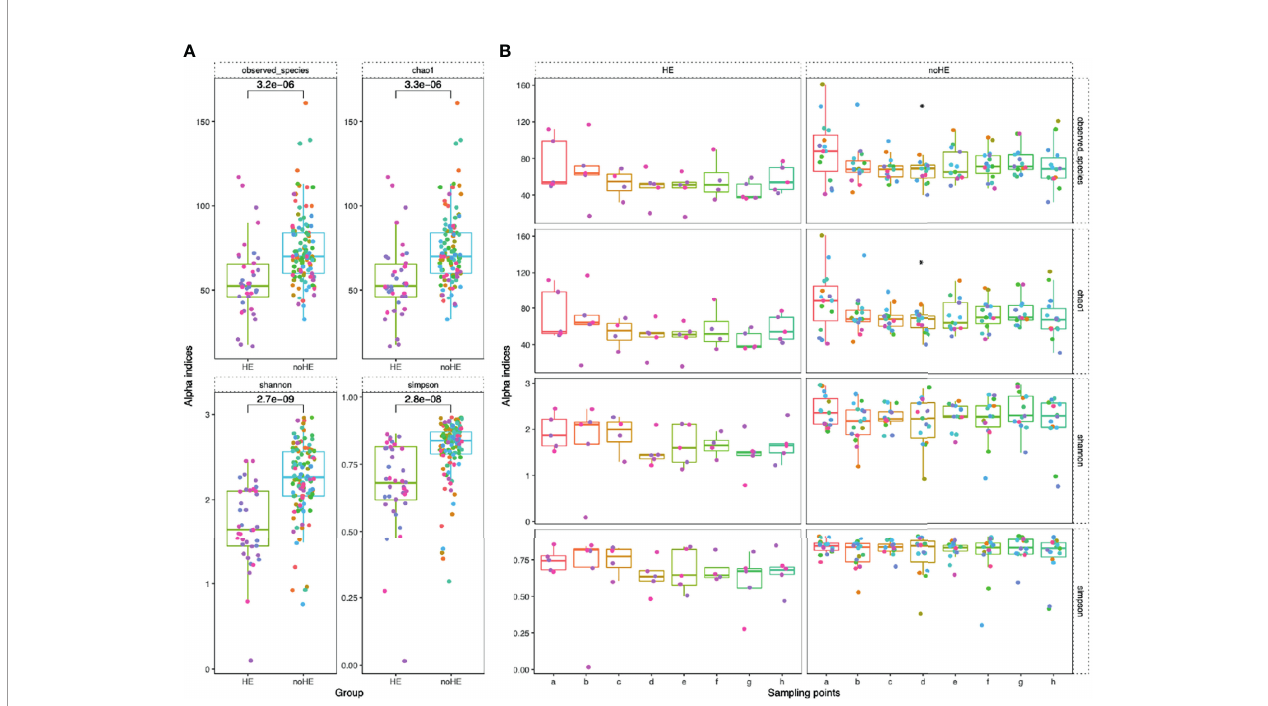
FIGURE 4 | Comparison of microbiota diversity (at the species level) in patients with and without HE. Each point in the fi gure represents a patient: individual colors represent an individual patient. (A) Comparison of the overall gut microbiota diversity in patients with and without HE. The diversity of the microbiota was signi fi cantly lower in patients with HE than in patients without HE. The numbers in the fi gure show the statistical P-values between the two groups. (B) Changes in gut microbiota diversity between patients with and without HE during drug administration. Horizontal coordinates denote sampling time points, with a – h representing Day 1, Week 1, Week 2, Week 4, Week 6, Week 8, Week 10, and Week 12, respectively. Vertical coordinates represent the four indicators of bacterial